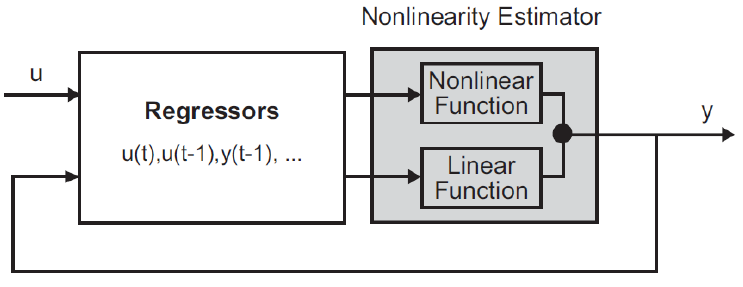
Figure 4. The Nonlinear ARX computes the output y in two stages [24]. u(t) are the model inputs, and y(t) are the model